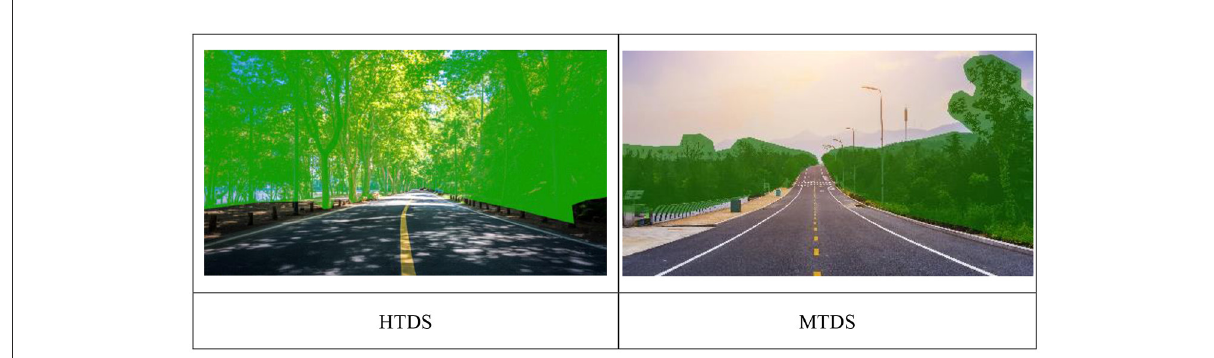
FIGURE3 Example images from the HTDS and MTDS that were shown to participants through cave virtual environment.